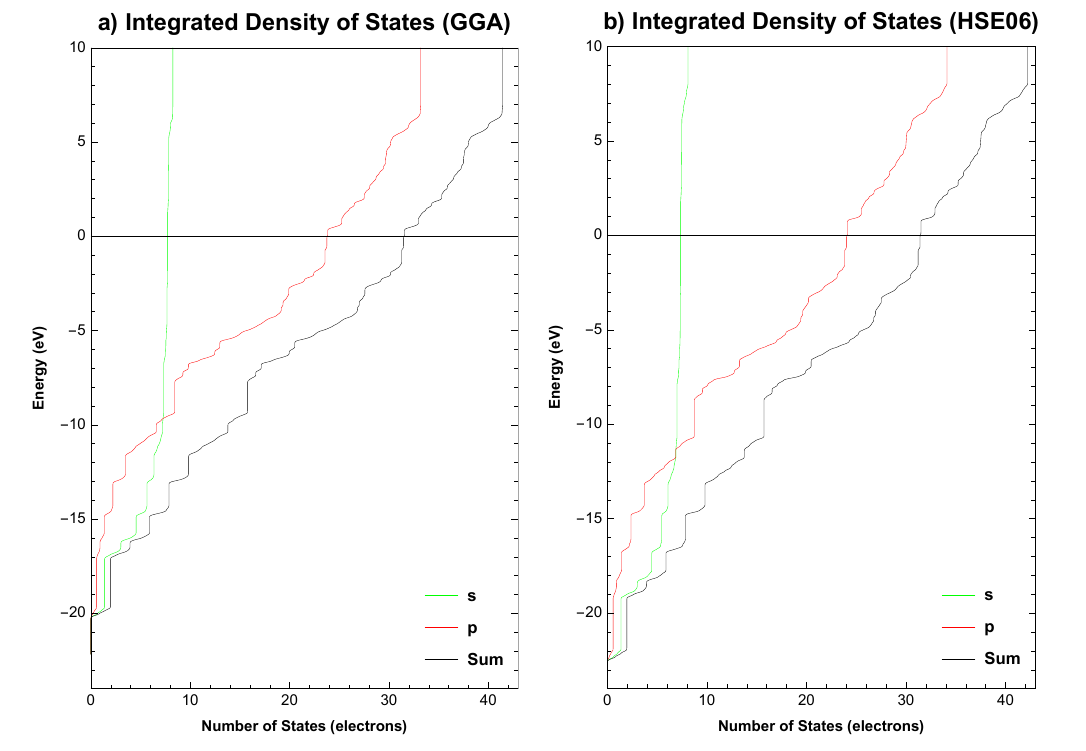
Figure 5. Anisotropic-cyclicgraphene —integrated total and partial density of states—( a ) (GGA functional) and ( b ) (HSE06 functional). The Fermi level E F is set to 0.